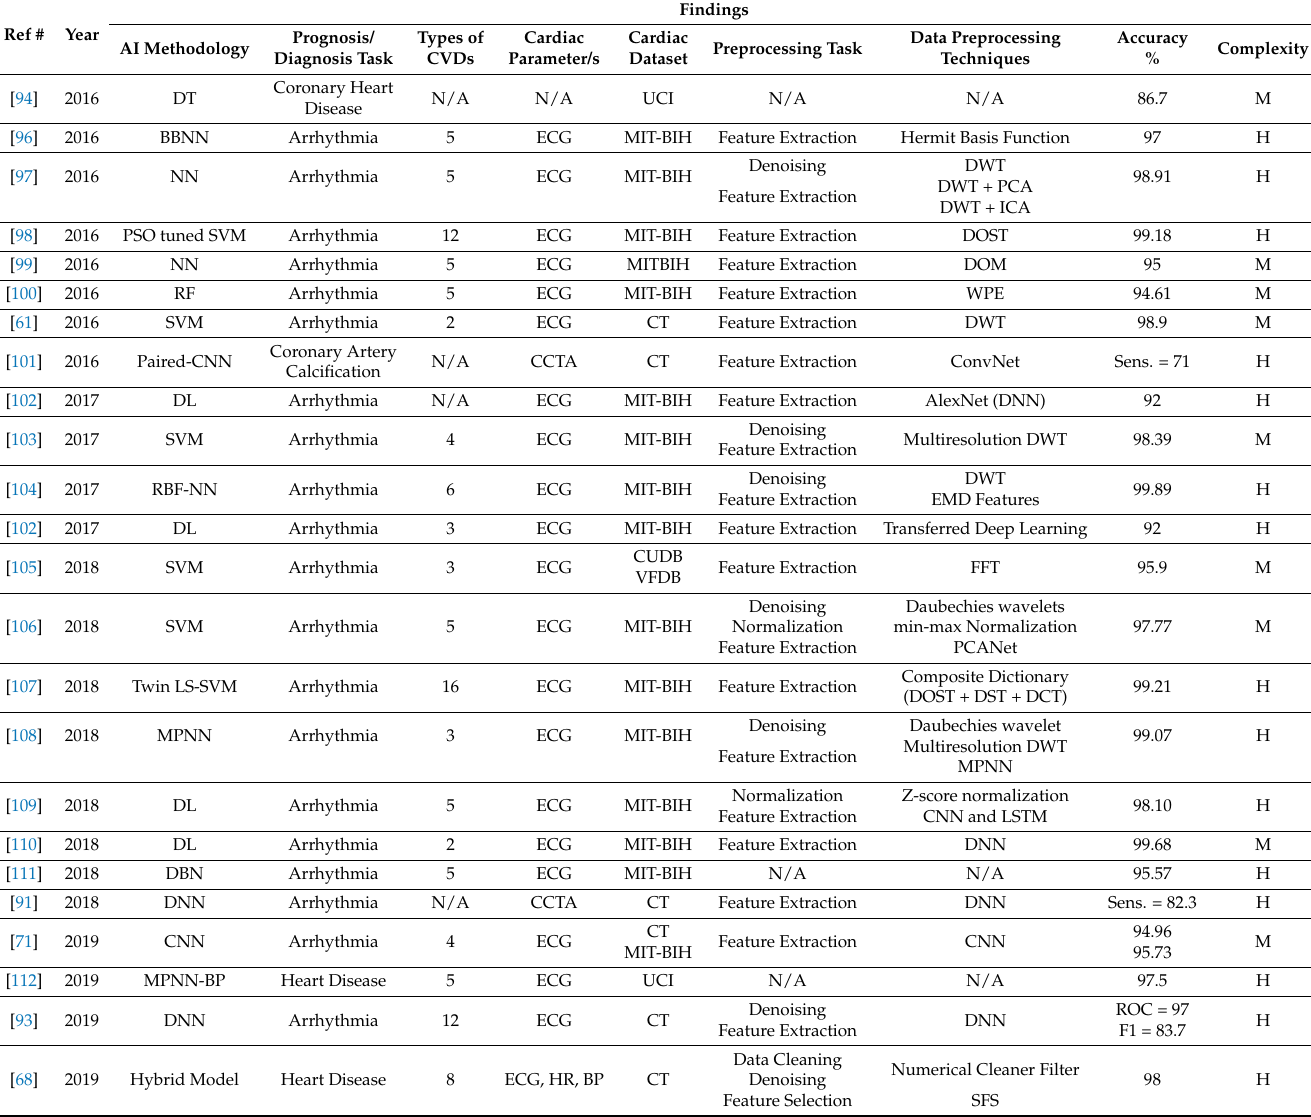
Table 14. Summary of AI-methodologies and data preprocessing techniques identified for E- Cardiology, from different